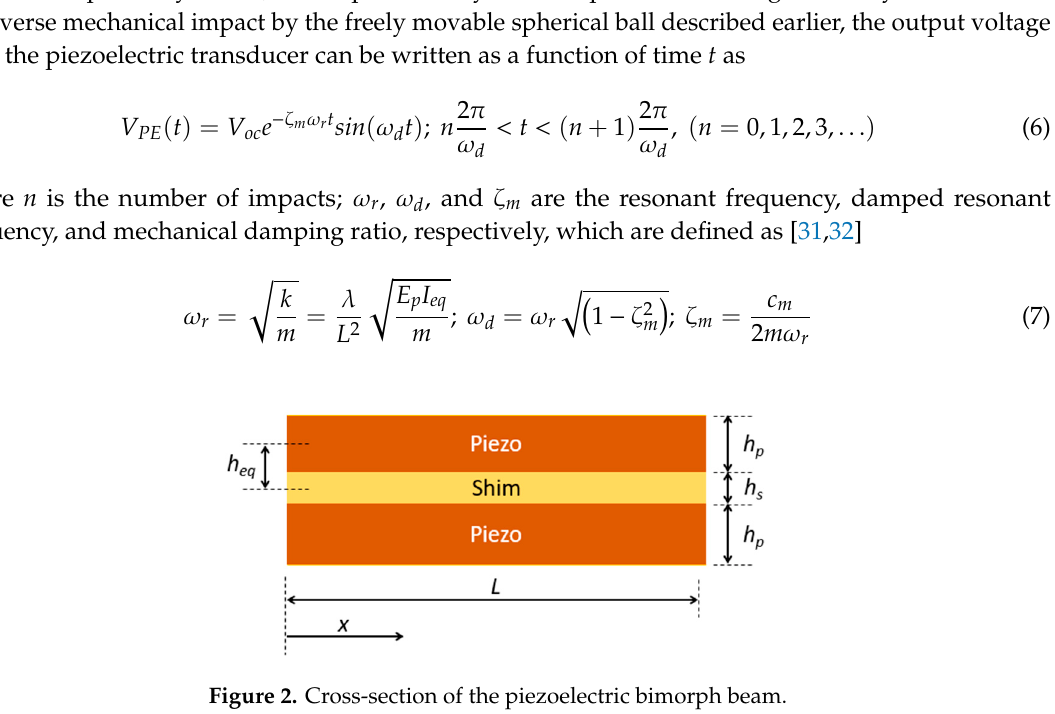
Figure 2. Cross-section of the piezoelectric bimorph beam.